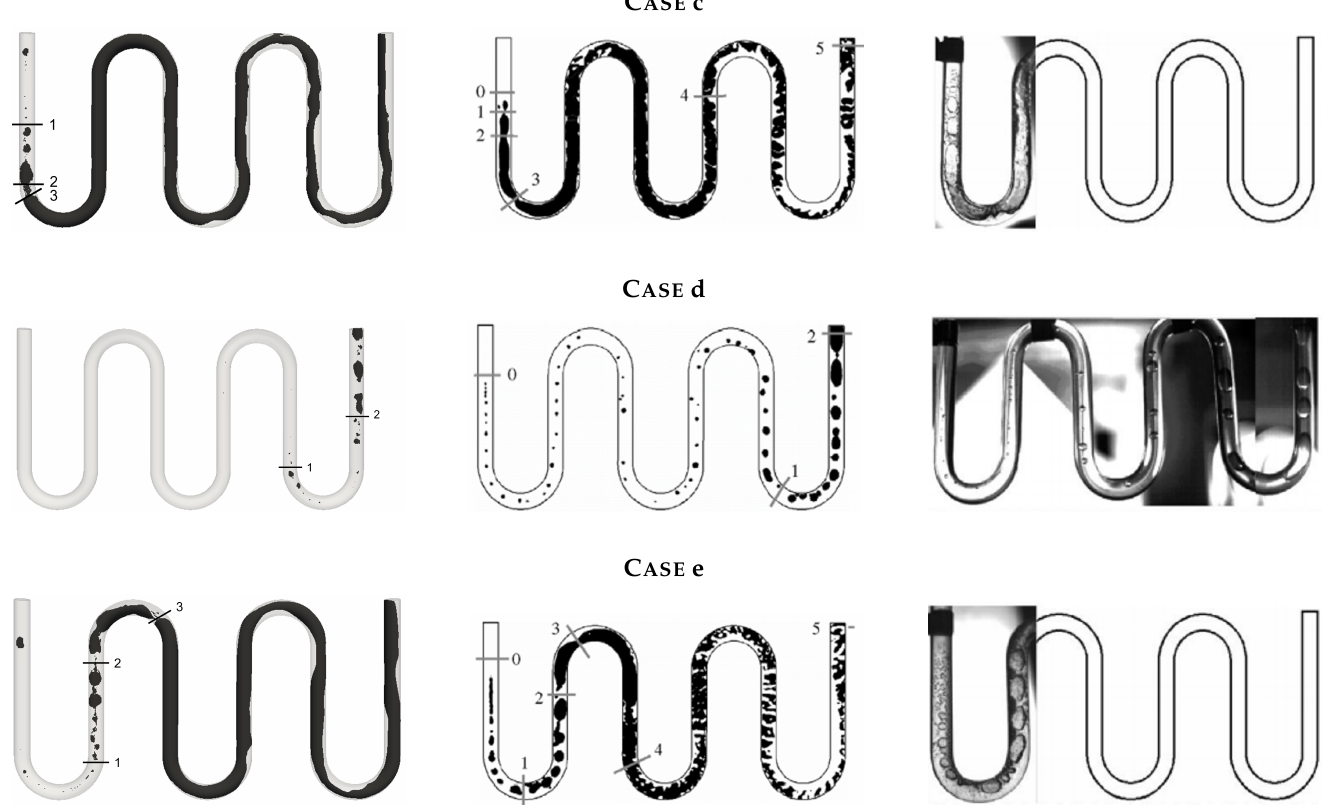
Figure 11. Comparison of the obtained regime transition with the results of Yang [1]. ( Left ): NEP- TUNE_CFD simulation—instantaneous visualization of isocontour α v = 0.5. ( Center ): Fluent simulations [1]. ( Right ): Experiment [1]. Each line corresponds to a different case (see Table 2 for the values of the different control parameters). Flow regimes 0–1: bubbly, 1–2: churn, 2–3: slug, 3–4: stratified, 4–5: